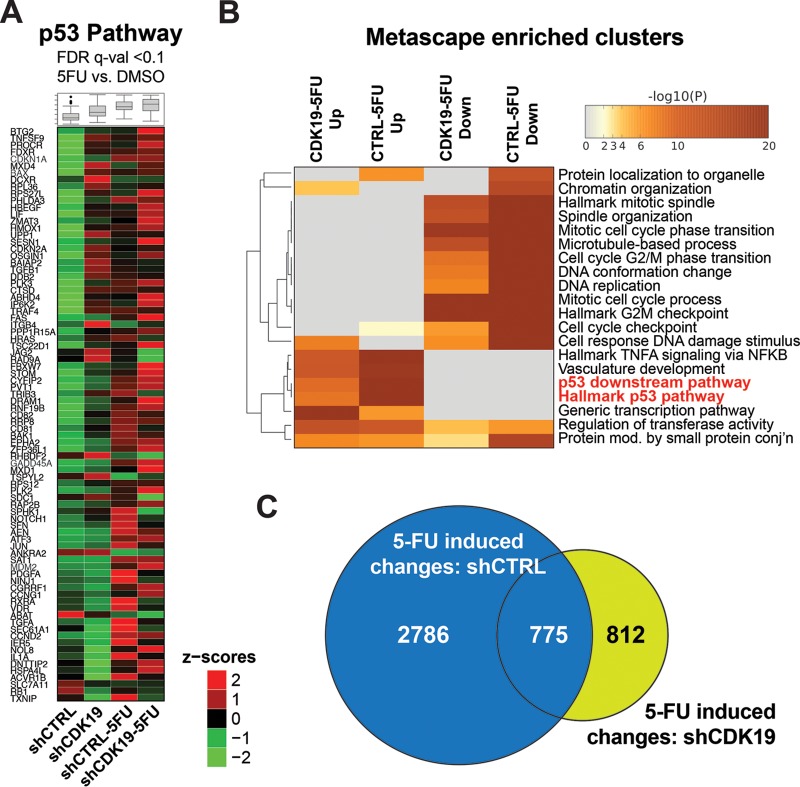
Differential p53 pathway activation in shCDK19 cells. (A) Heat maps showing average expression (calculated from the RPKM) of p53 pathway genes under conditions tested in this study; only genes meeting an FDR q < 0.1 threshold are shown. (B) Heat map of Metascape-enriched clusters (each cluster contains multiple gene sets to eliminate redundancy) in 5-FU-treated cells (shCDK19 or shCTRL), separated by up- or downregulated. Analysis used genes meeting an FDR q < 0.1 threshold. (C) Venn diagram showing overlap of differentially expressed genes in shCTRL versus shCDK19 cells upon 5-FU treatment (i.e., shCTRL data from Fig. 4A and shCDK19 data from Fig. 5A).